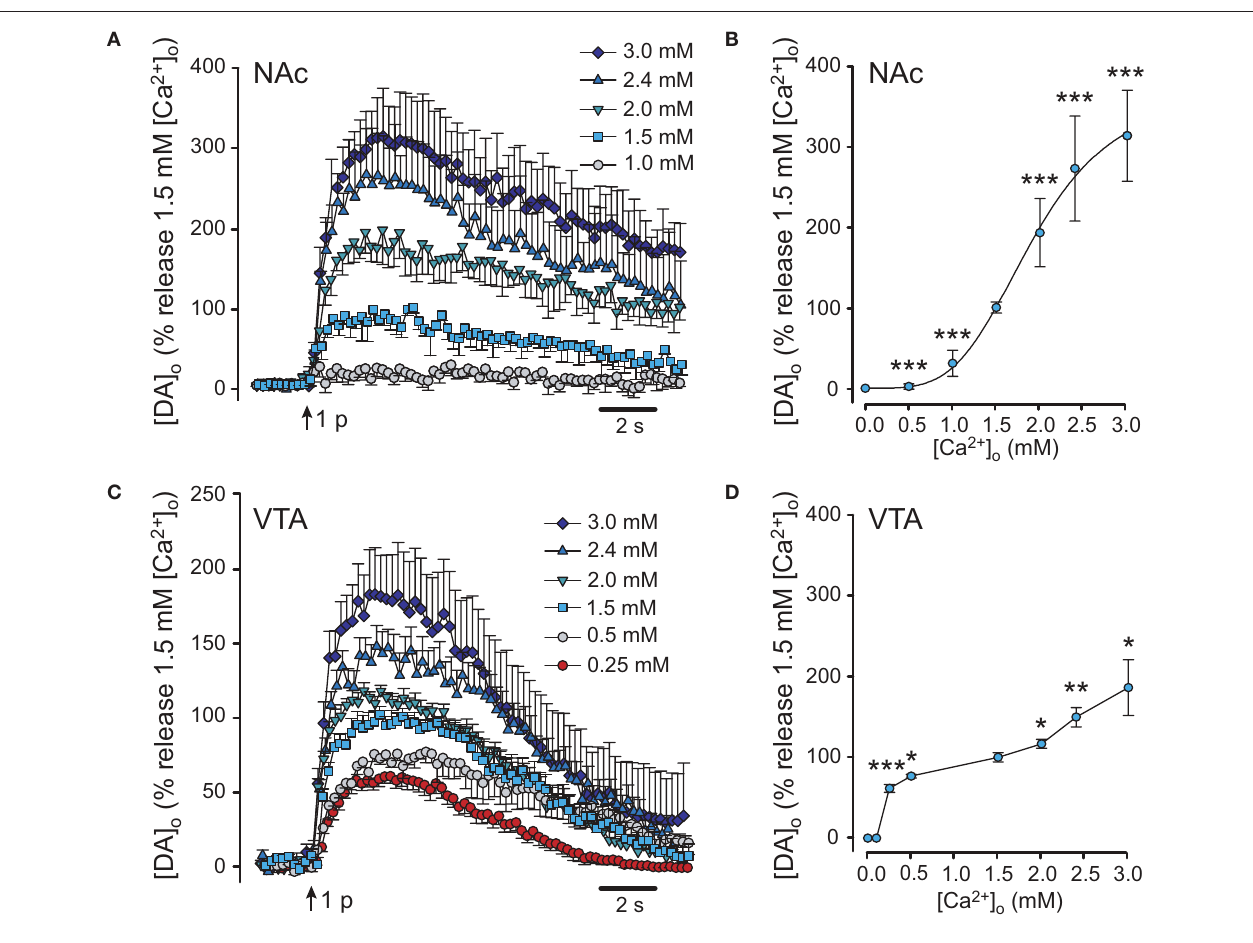
Figure 2 | The Ca 2 + dependence of DA release in NAc and VTA. (A) Average evoked [DA] in the presence of varying [Ca 2 + ] in NAc shell. o o Maximum [DA] in 1.5 mM [Ca 2 + ] in NAc was taken as 100%. As in o o dorsal striatum, synaptic DA release in NAc could not be evoked in [Ca 2 + ] was increased ≤ 0.5 mM, but increased progressively as [Ca 2 + ] o o from 1.0 to 3.0 mM. ( B ) Ca 2 + dependence of evoked DA release in NAc. Significance of difference from peak [DA] in 1.5 mM [Ca 2 + ] is indicated by o o *** p < 0.001 ( n = 7). ( C ) Average evoked [DA] in the VTA the presence of o varying [Ca 2 + ] . Maximum [DA] in 1.5 mM [Ca 2 + ] in VTA was taken as o o o